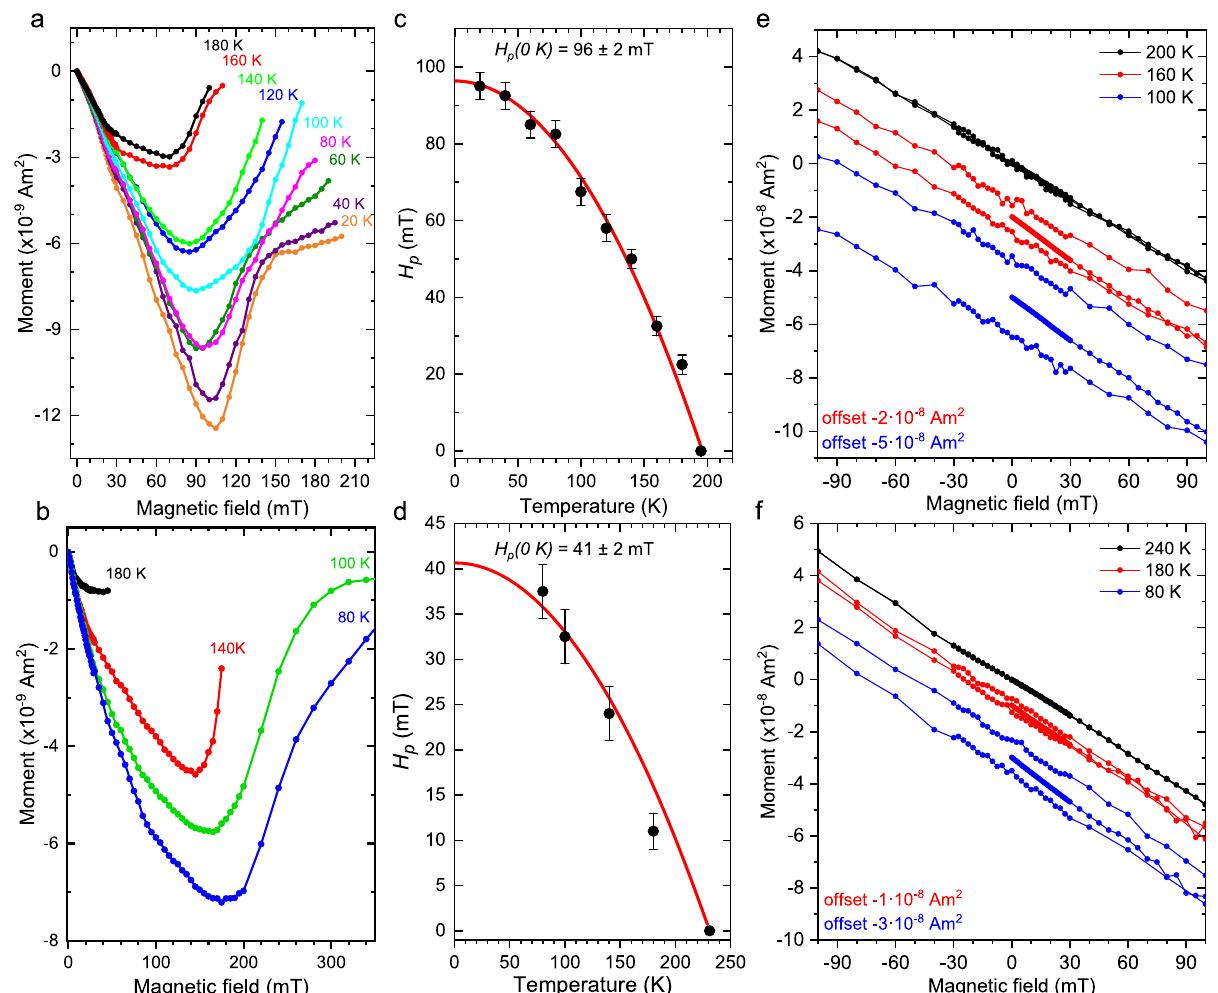
Fig. 3 M ( H ) magnetization data for Im-3m -H 3 S and Fm-3m -LaH 10 at high pressure. a , b Virgin curves of the M ( H ) magnetization data for the Im-3m -H 3 S phase at P S = 155 ± 5 GPa and the Fm-3m -LaH 10 phase at P S = 130 ± 8 GPa at selected temperatures. The curves were superimposed for a better representation; so the linear trend of M ( H ) dependences coincides for measurements at different temperatures. c , d Temperature dependence of a penetration fi eld H p for Im-3m -H 3 S and Fm-3m -LaH 10 derived from the virgin curves of M ( H ) magnetization data. Black circles and red curves correspond to the experimental data and fi ts, respectively. e , f Hysteretic part of M ( H ) measurements of H 3 S and LaH 10 in the normal metallic state above T c and the superconducting state below T c ,